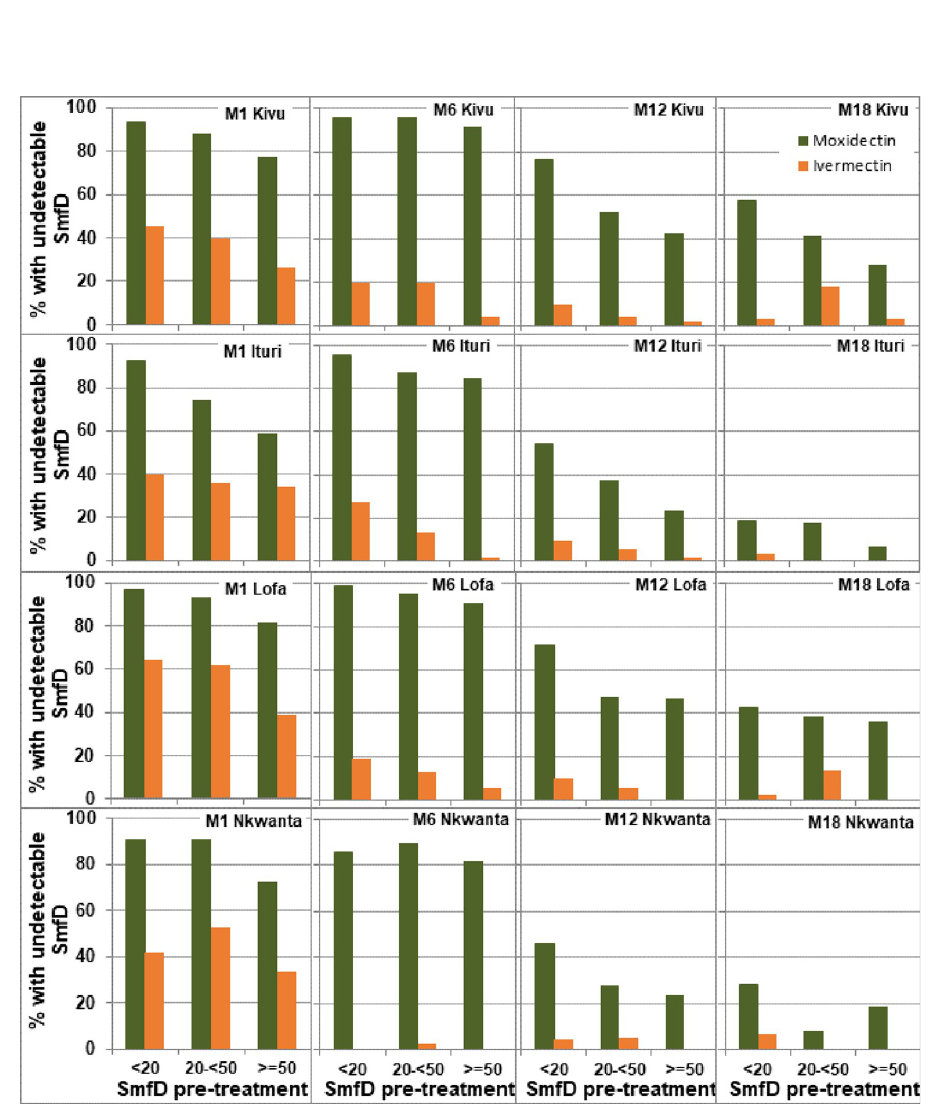
Fig 4. Percentage of participants with undetectable SmfD by study area, pre-treatment SmfD and post-treatment time. M1, M6, M12, M18: month 1, 6, 12 18 after treatment (for numbers treated see Fig 3, for numbers with follow up data at each time point, see Tables S4-S8 in S 1 File